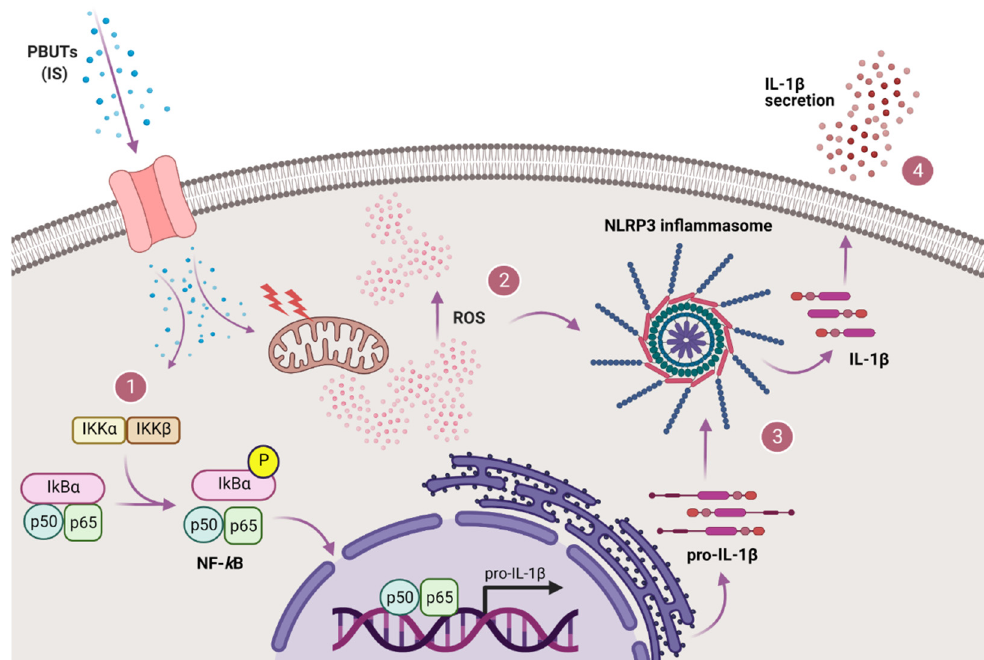
Figure 8. Proposed mechanism of PBUTs-ROS-driven NLRP3 inflammasome-mediated IL-1 β production in proximal tubule epithelial cells. After reaching the cells, IS and other PBUTs lead to both (1) NF- κ B signaling activation (p50/p65 translocation to the nucleus and transcription initiation) and (2) ROS production and oxidative stress. Following enhanced transcription of IL-1 β and production of pro-IL-1 β , ROS-mediated NLRP3 inflammasome is assembled thus leading to caspase-1 activation, and subsequent (3) proteolytic cleavage of pro-IL-1 β into IL-1 β that is (4) secreted by the cells. Created with BioRender.com.